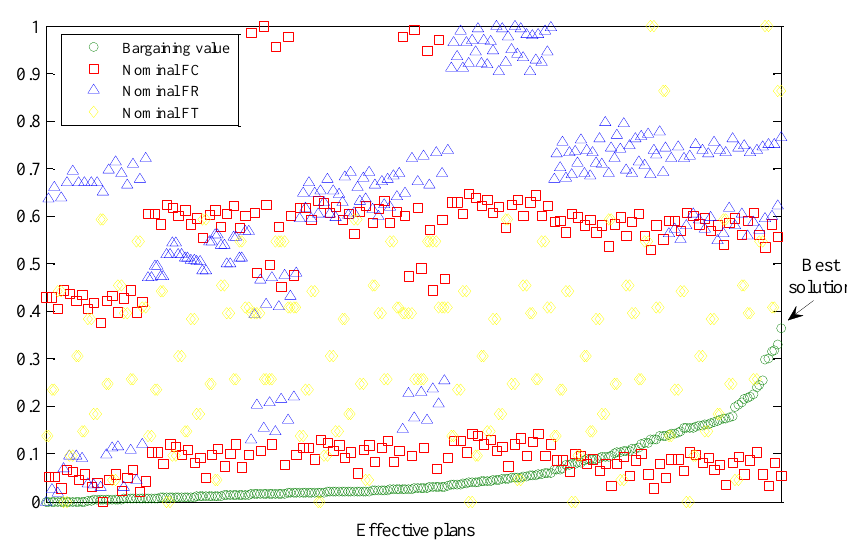
Figure 9. Bargaining function value and the normalized value of each objective.